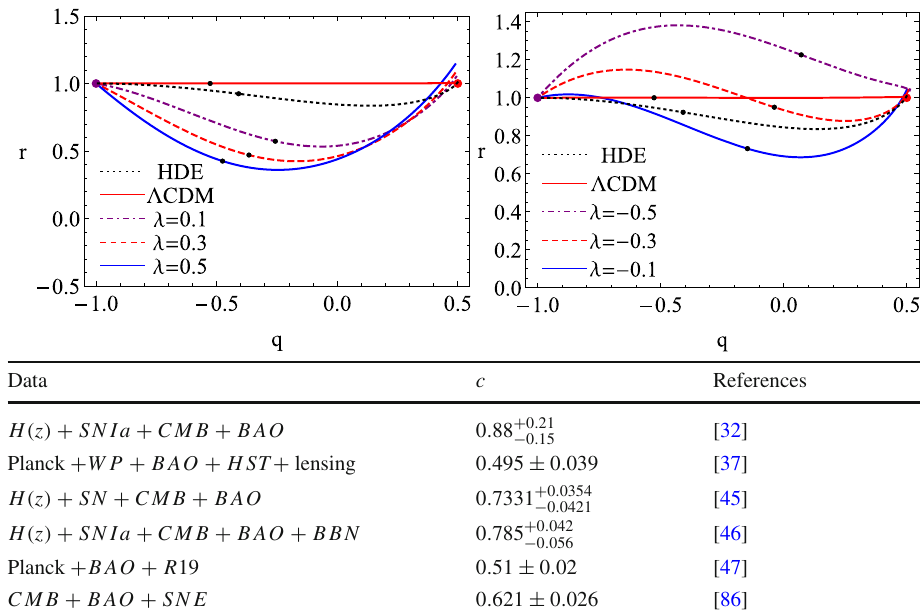
Table 3 Examples for